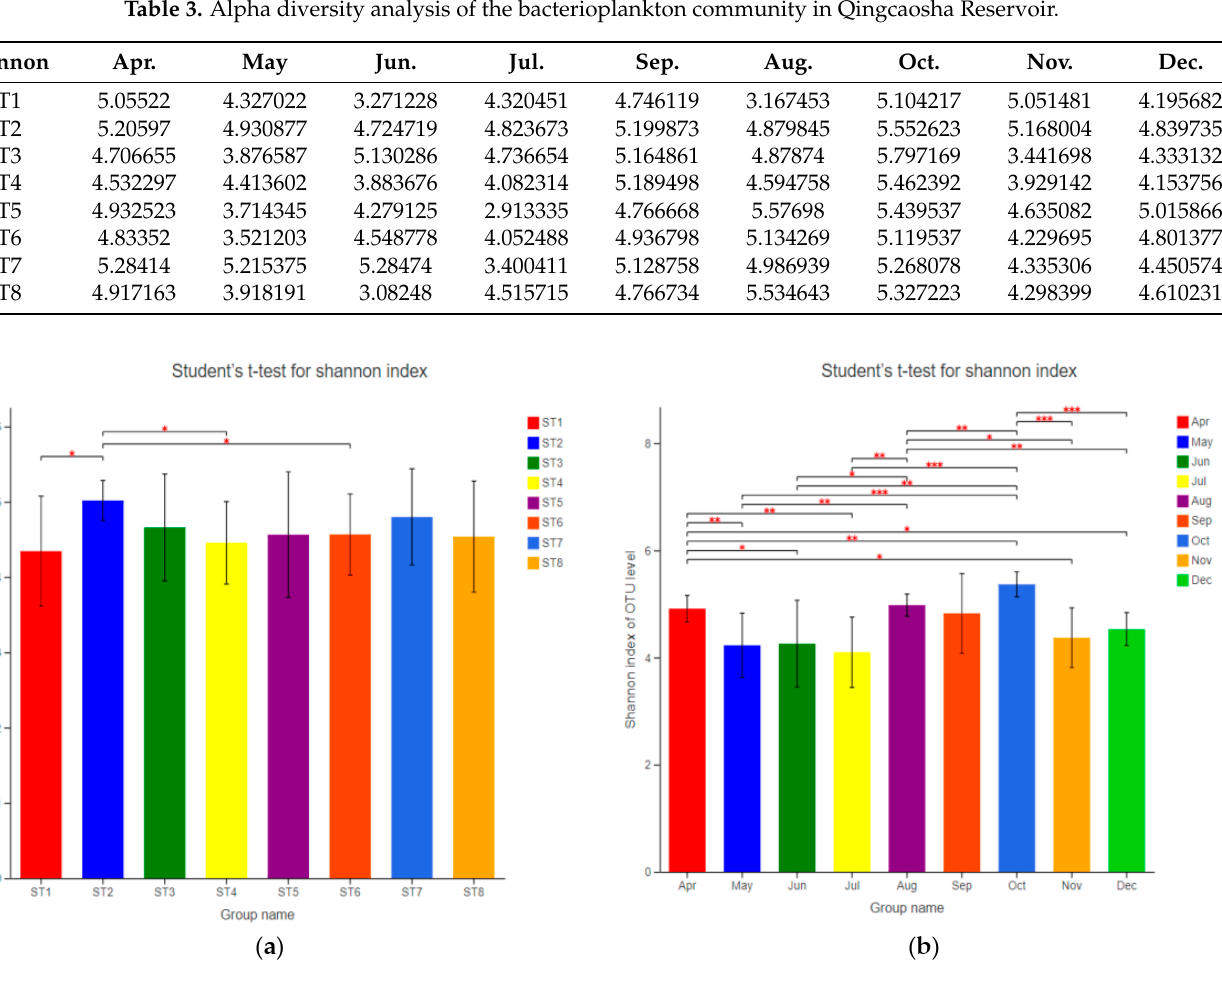
Figure 4. Inspection of differences in Shannon index values between various groups in the reservoir, spatial groups ( a ) and temporal groups ( b ). This diagram shows the significant differences between the selected two groups of samples, and the two groups of markers with significant differences (0.01 < p ≤ 0.05 marked *, 0.001 < p ≤ 0.01 marked **, p ≤ 0.001 marked ***). The X-axis is the grouping name, and Y-axis is the index average of each group.